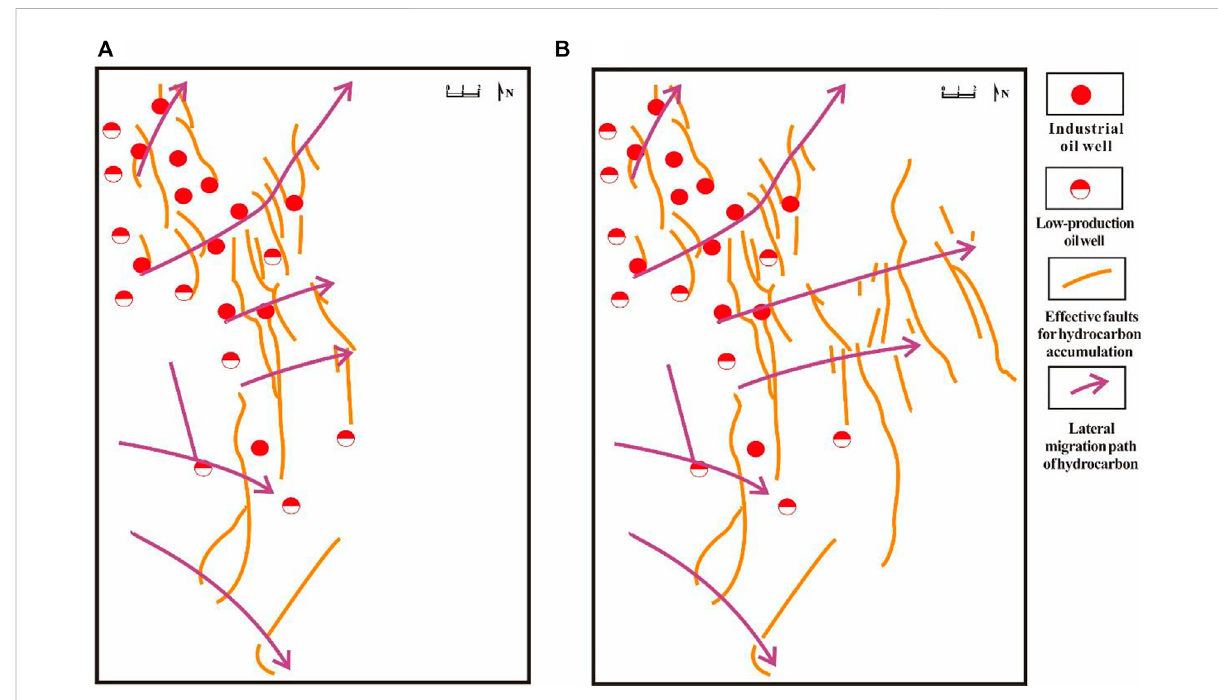
Relationship between hydrocarbon accumulating effective faults and hydrocarbon distribution in the fi rst member of the Nantun Formation